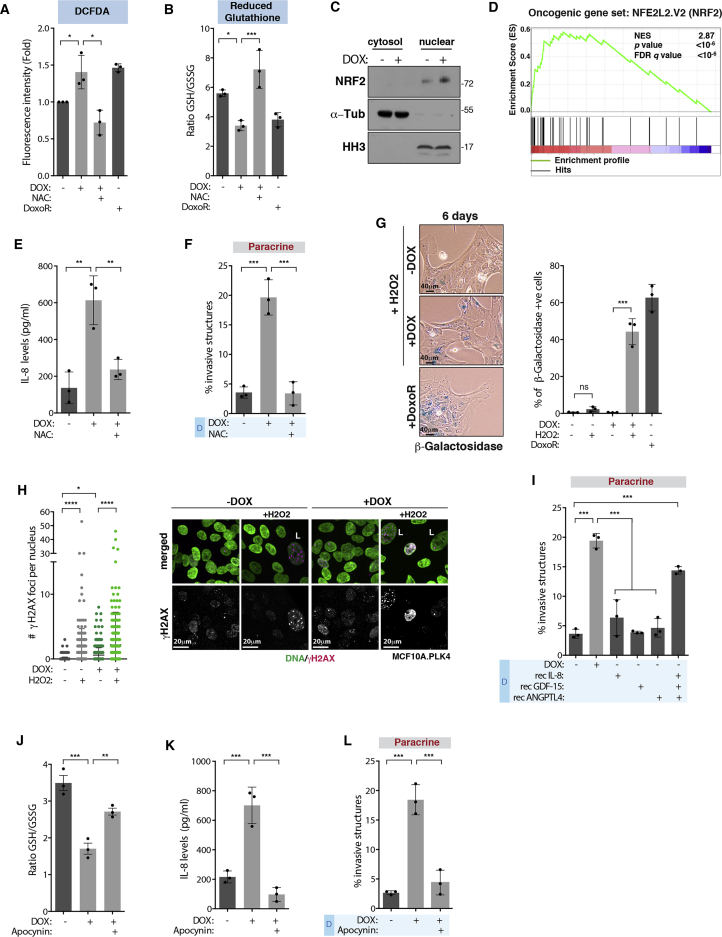
Increased ROS Levels in Cells with Extra Centrosomes Drive Secretion(A and B) (A) Levels of intracellular ROS using DCFDA or (B) by measuring the ratio of GSH/GSSG (48 hr).(C) NRF2 protein levels in the cytosolic and nuclear fractions.(D) Gene expression profile of cells with extra centrosomes (48 hr) compared to an NRF2 (NFE2L2)-induced gene-set signature.(E) IL-8 secretion in after NAC treatment.(F) Quantification of invasive structures.(G) Left, cells stained for β-galactosidase (blue). Right, quantification of β-galactosidase positive cells. Scale bar: 40 μM.(H) Left, quantification of γH2AX foci. Right, cells were stained for DNA (green) and γH2AX (magenta). L, large nuclei. Number of cells MCF10A.PLK4 −DOX = 469; −DOX+H2O2 = 518; +DOX = 466; +DOX+H2O2 = 377. Scale bar: 20 μM.(I) Quantification of invasive structures.(J) Ratio of GSH/GSSG.(K) IL-8 secretion in cells treated with apocynin.(L) Quantification of invasive structures. For all graphics error bars, represent mean ± SD from three independent experiments. ∗p < 0.05, ∗∗p < 0.01, ∗∗∗p < 0.001, ∗∗∗∗p < 0.0001; ns not significant.See also Figure S6 and Table S1.